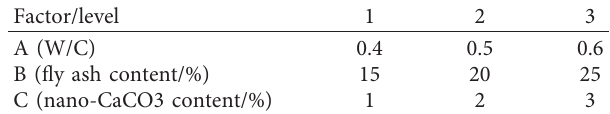
Table 3: Factors and levels.